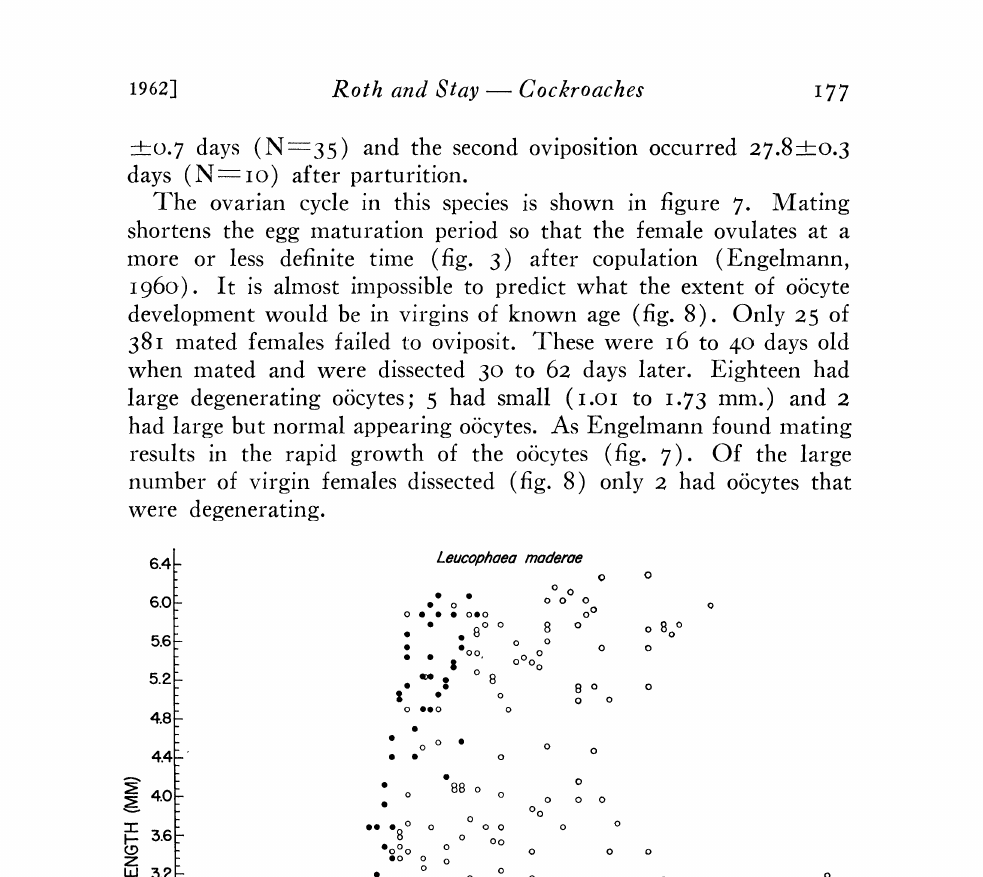
. Fig. 8. G[otb o o6cyte n mated and acb pont epesets one female. emale to 23 day old.